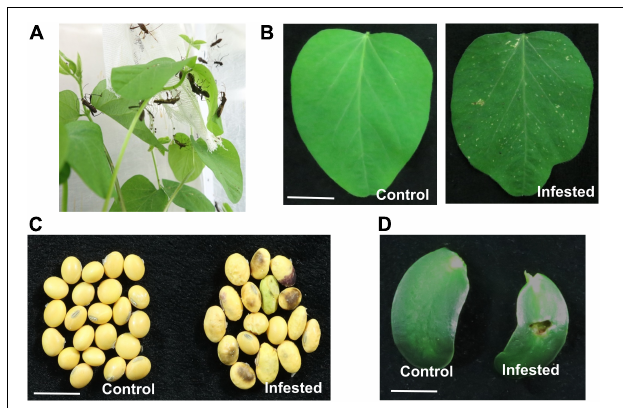
FIGURE 1 | Riptortus pedestris feeding induces soybean cell death. (A) Riptortus pedestris feeds on soybean leaves. (B–D) Riptortus pedestris induces cell death on soybean leaves, seeds, and cotyledons. Infested leaves were photographed 5 days after adult feeding. Control leaves means were not fed upon. Bar = 1